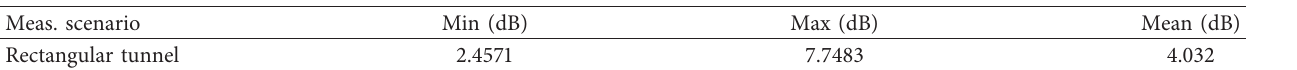
Table 3: Statistics of K